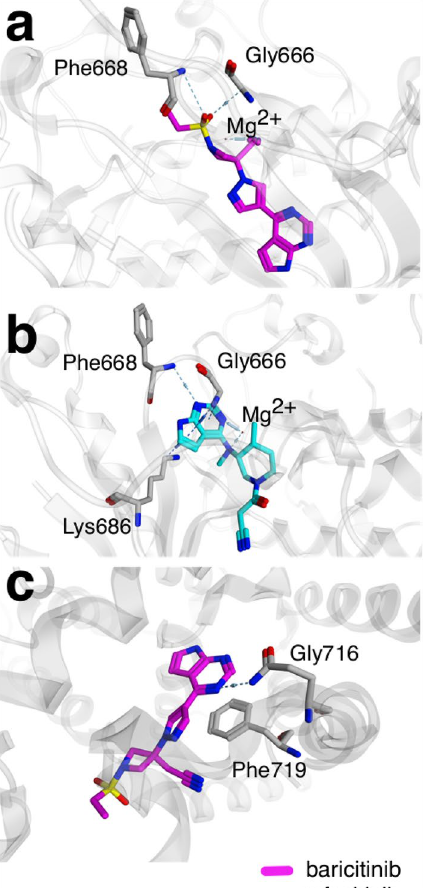
Figure 2. Predicted docking pose of baricitinib and tofacitinib on the identified targets. Predicted docking pose of baricitinib ( a ) and tofacitinib ( b ) in the binding site of PKN2 (PDB-ID: 4CRS 34 ). Predicted binding pose of baricitinib ( c ) in the binding site of PDE10A (PDB-ID: 5C28 35